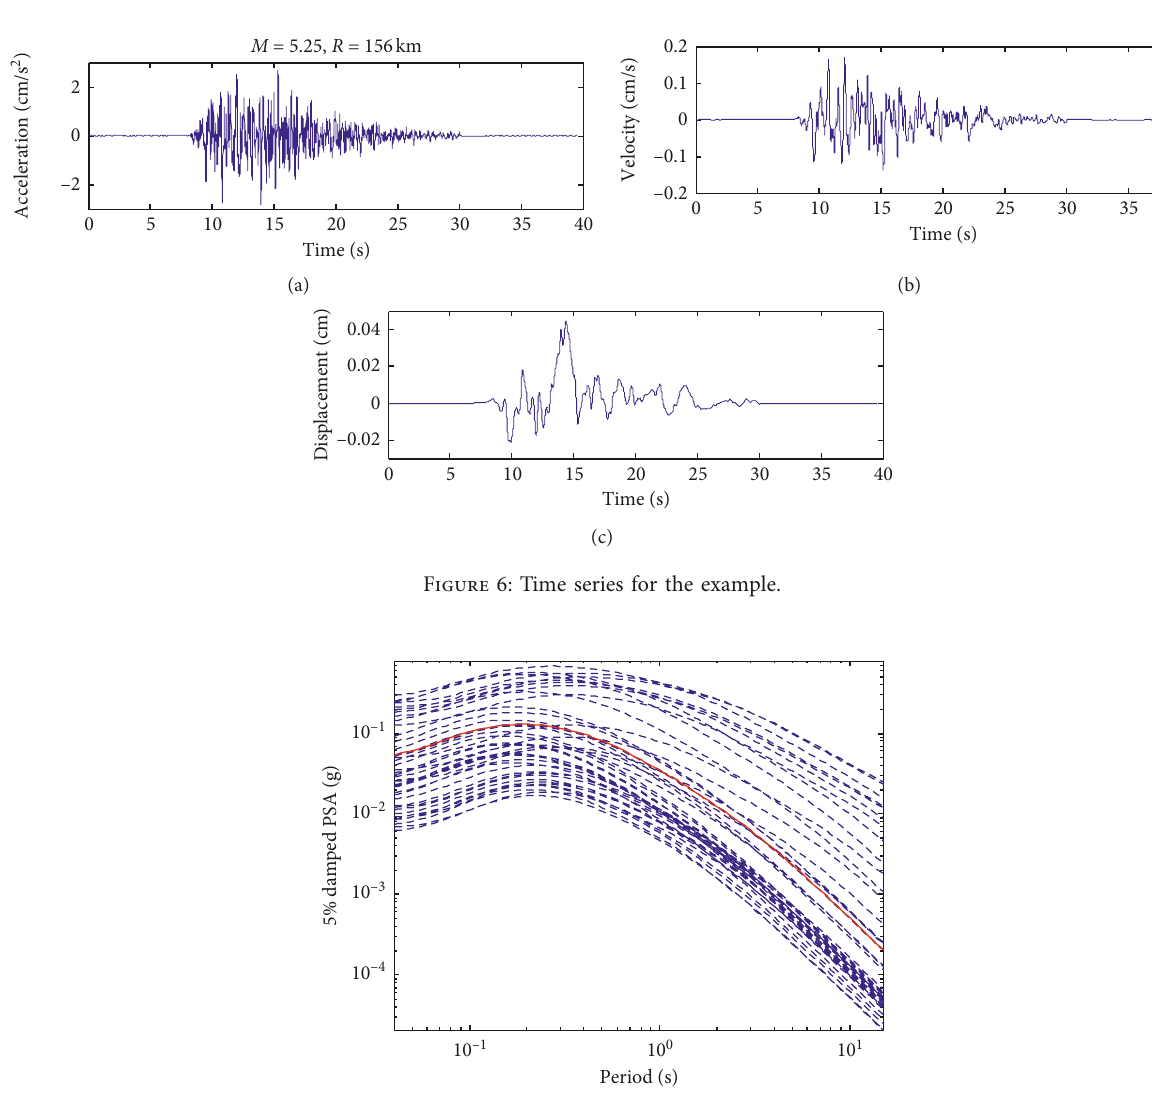
≥ 4 . 7; from 70 BC to May 2006). s